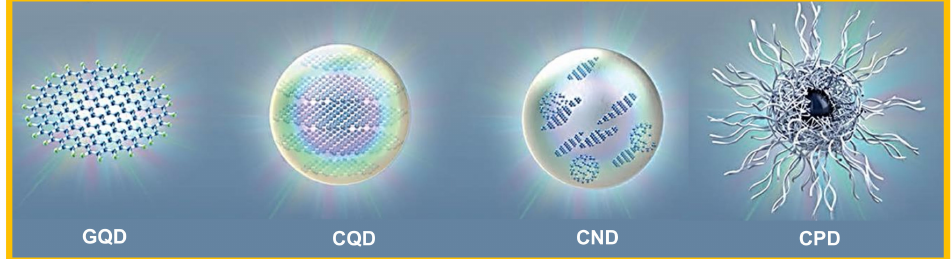
Figure 2. Classification of CDs. Adapted from [47], 2019, Wiley. GQD: graphene quantum dot; CQD: carbon quantum dot; CND: carbon nanodot; CPD: carbonized polymer